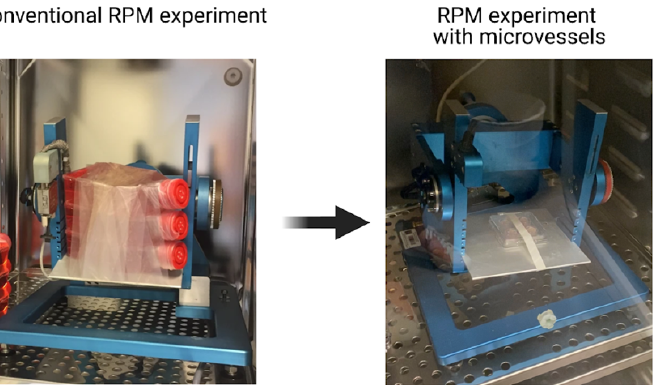
Figure 1. Comparison of experimental setup using conventional large vessels (left) and the designed microvessels (right). Figure depicting a conventional RPM experimental adapted from Buken et al. [13].